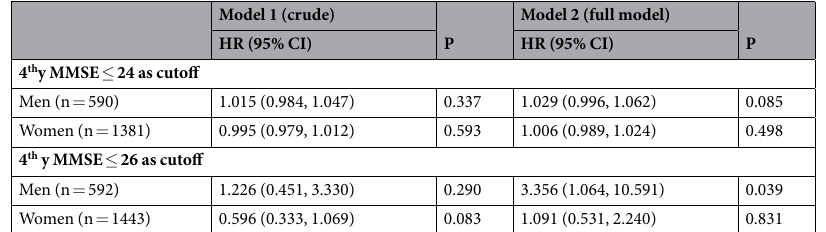
Table 3. Hazard ratios (95% CI) of impaired cognition (MMSE ≤ 24 and ≤ 26) at 4 th year follow-up by dietary acrylamide exposure among non-smoking Chinese elderly men and women. Data analysis was conducted by logistic regression model. Hazard rations (HR): Risk of MMSE ≤ 24 or ≤ 26 with an increase of 1 µ g/d acrylamide intake. Adjusted variables included age (y), education, PASE total scores, dietary carbohydrate intake (% total energy), total AHA scores, baseline body weight, coffee (ml/d), tea drinking (ml/d), alcohol drinking (ml/d), medical history of diabetes (yes/no), stroke (yes/no), hypertension (yes/no), heart infarction (yes/no), any cancers (yes/no), total isoflavoens intake (mg/d), fruit and vegetables intakes (g/1000 kcal), fish consumption (g/1000 kcal). Total AHA scores were estimated based on the adherence index of American Heart Association on dietary and life style recommendations. MMSE: questionnaire for Mini-Mental State